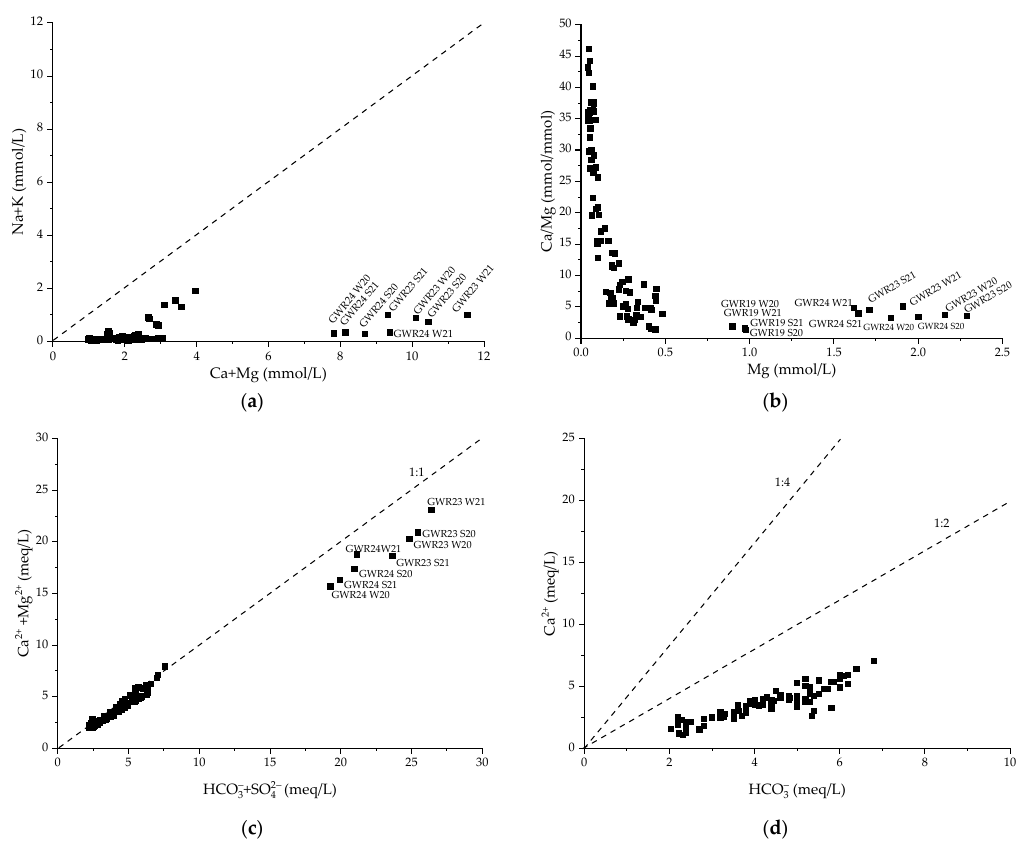
Figure 6. Sca tt er plots showing possible sources of elements in the di ff erent seasons in the two stud- Figure 6. Scatter plots showing possible sources of elements in the different seasons in the two studied ied regions: ( a ) Na+K versus Ca+Mg, ( b ) Ca/Mg versus Mg, ( c ) HCO 3 − +SO 42 − versus Ca 2+ +Mg 2+ , and regions: ( a ) Na+K versus Ca+Mg, ( b ) Ca/Mg versus Mg, ( c ) HCO 3 − +SO 4 2 − versus Ca 2+ +Mg 2+ , and ( d ) HCO 3 − versus Ca 2+. ( d ) HCO 3 − versus Ca 2+ The ratio of (Ca 2+ +Mg 2+ ) to (HCO 3 − +SO 42 − ) in most of the samples was around 1, indi-